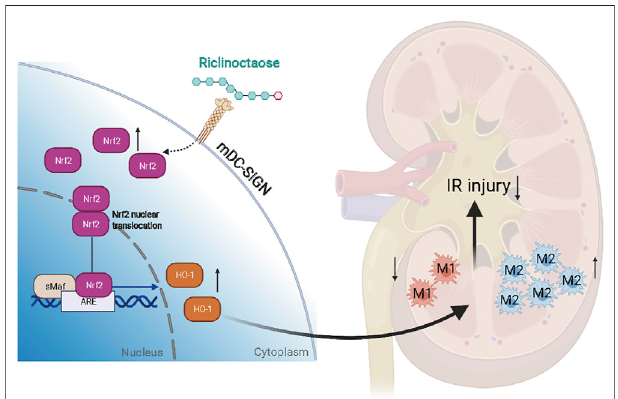
FIGURE 8 | A schematic summary of this study, showing that riclinoctaose protects against renal ischemia-reperfusion injury in mice. In detail, riclinoctaose activates the Nrf-2/HO-1 pathway, inhibits ischemia- reperfusion-induced M1 macrophage polarization, and facilitates M2 macrophage recruitment into the